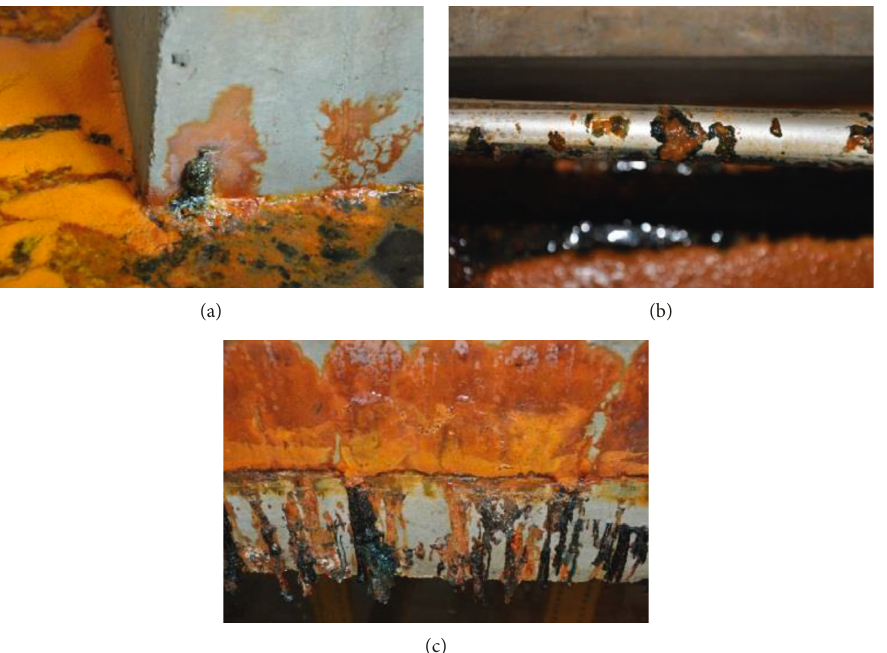
Figure 6: (a) Rust on the specimen. (b) Rust on the stainless steel tube. (c) The specimen after accelerated